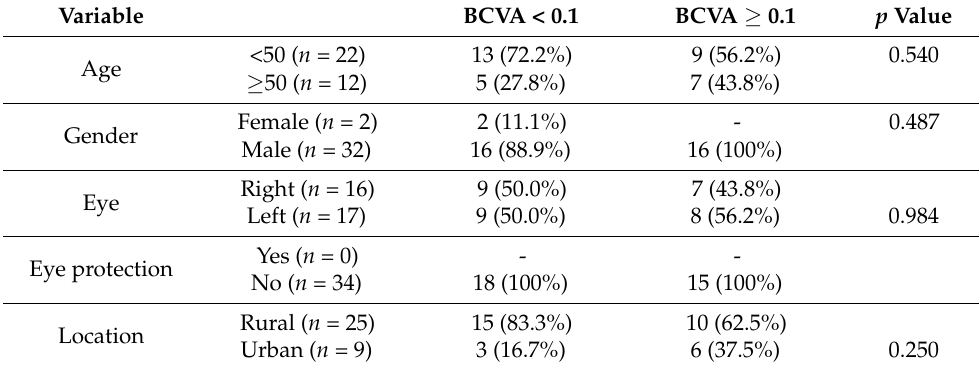
Table 1. Demographic